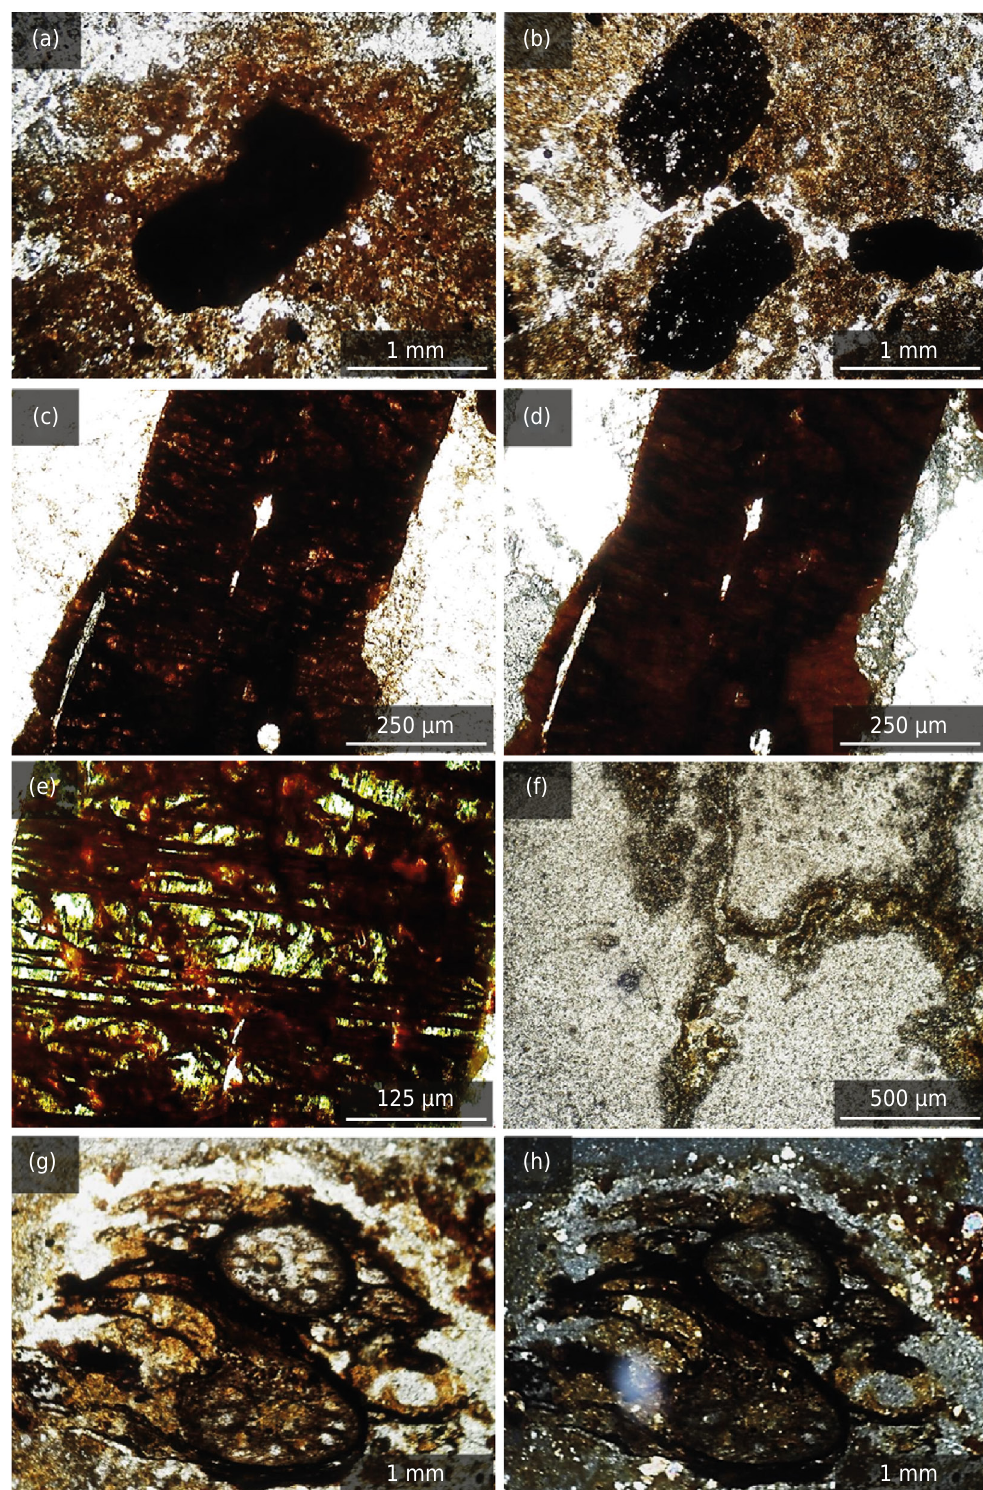
Figure 4. Optical microscopy photographs of the main micromorphological features of the profiles. (a) Nodule aggregates in the Bt3 horizon of P3 (ppl); (b) Impregnative nodules in the Bt horizon of P4 (ppl); (c) Possible altered green hornblende surrounded by oxidized thin material in the BC3 horizon of P2 (ppl); (d) Possible altered green hornblende (xpl); (e) Remnants of color and cleavage of possible green hornblende in the BC3 horizon of P2 (ppl); (f) Coatings and fillings in inter-aggregate planar voids in the BC3 horizon of P2 (ppl); (g) Impregnation of root tissue by fine red and yellow-red materials in the Bt1 horizon of P3 (ppl); and (h) Impregnation of root tissue by fine materials